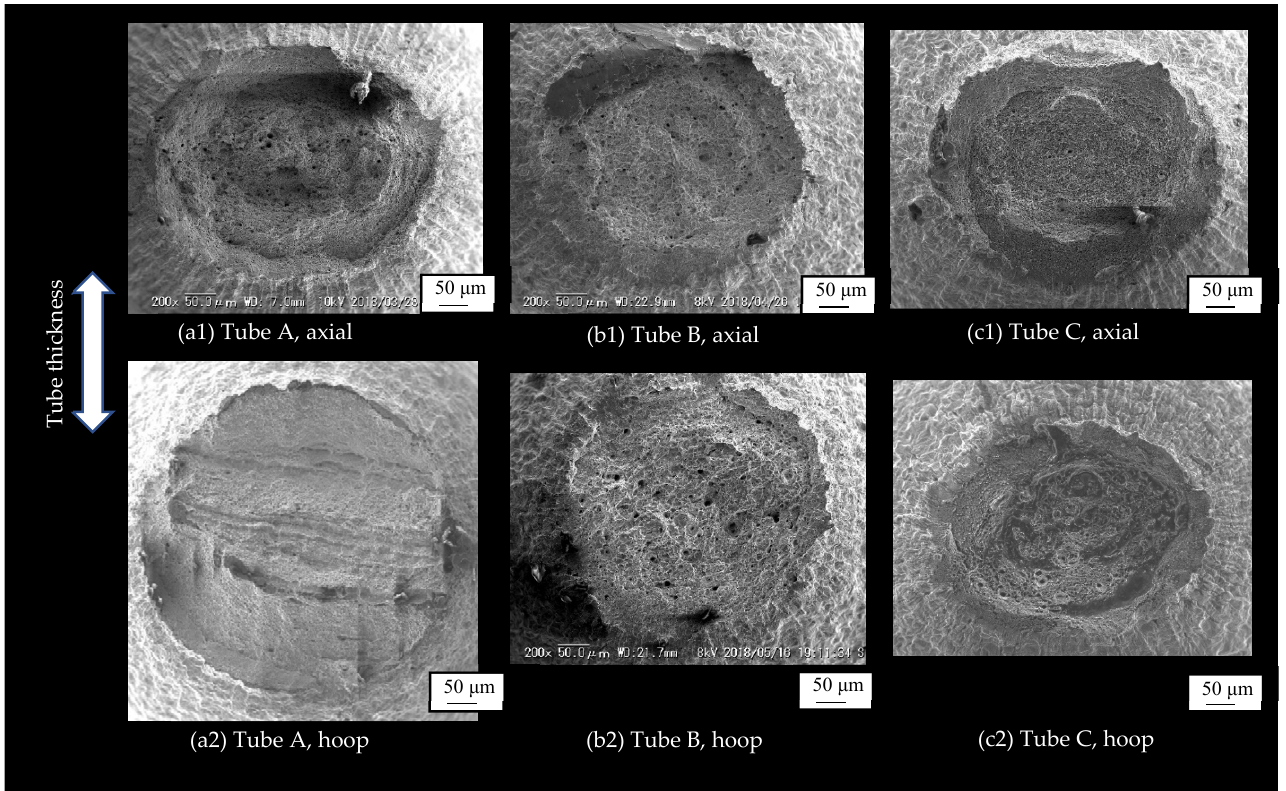
Figure 10. Fracture surface of the small round-bar specimen after tensile tests.